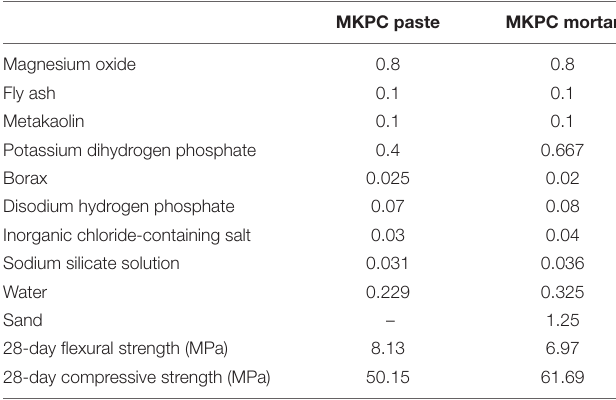
TABLE 1 | Mix proportions and strength of MKPC paste and